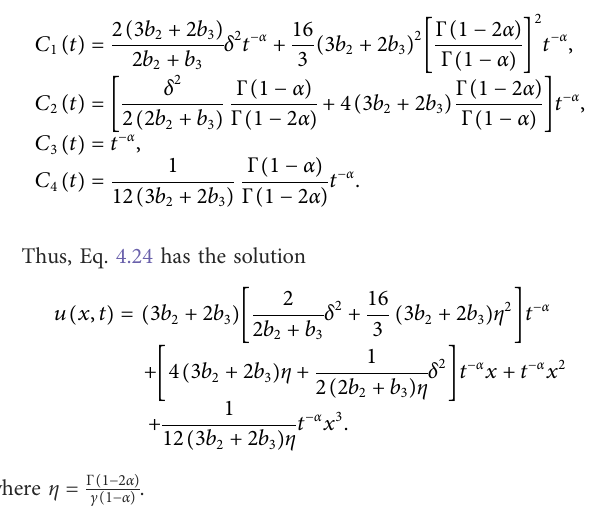
E 2 , 1 − λ 2 t 2 (cid:25)